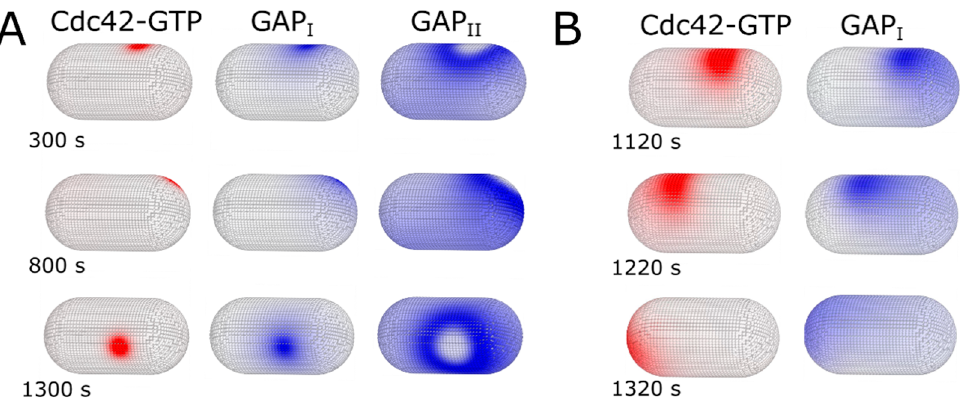
Figure 8. Snapshots of model results when Cdc42 activation is not biased at cell tips (limit of 𝜆 → ∞ ). With other parameters same as Table 1, the system towards uniform activation. ( A ) Patch appearance and disappearance for 𝑘 (cid:2868)(cid:3043) = 0.01 μ m 2 /s increased four times compared to Table 1. ( B ) Traveling wave behavior with parameters from Table 1 except 𝑘 (cid:2868)(cid:3043) = 0.01 μ m 2 /s and 𝑘 (cid:2873)(cid:3041) = 0 , which eliminates GAP II .